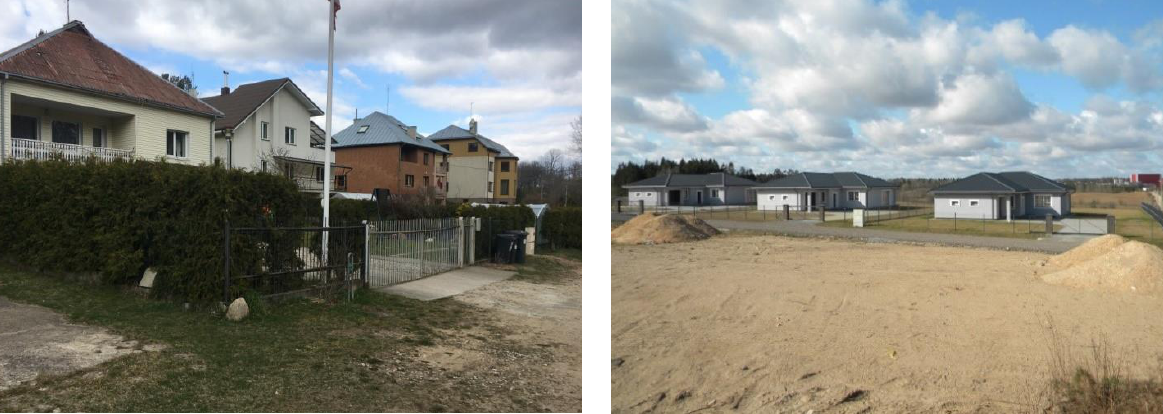
Fig. 7. Suburban houses built in the 1990s within the city municipality (left) and the most recent developments outside the city (right) (Source: